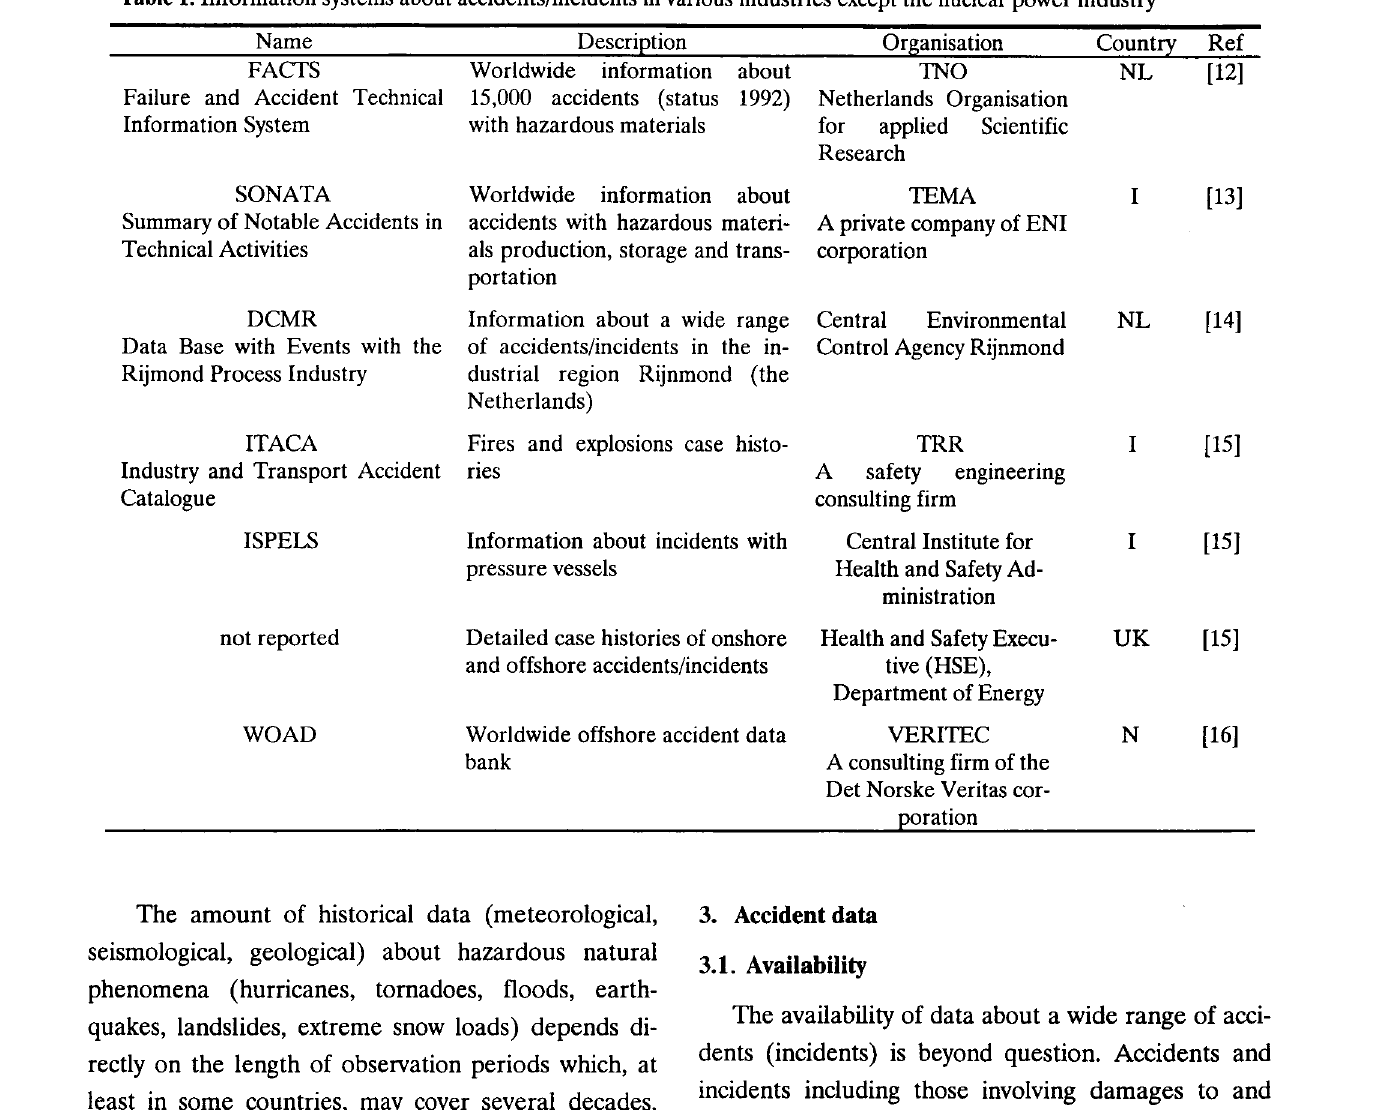
Table 1. Information systems about accidents/incidents in various industries except the nuclear power industry